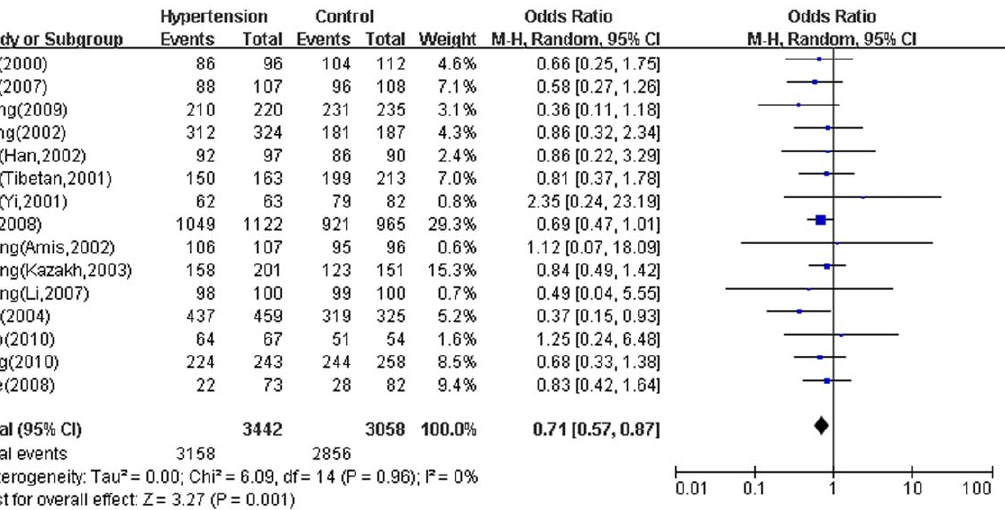
Figure 2. Meta-analysis for the overall association between the A-6G polymorphism and hypertension under the dominant genetic model. Figure 2 shows that the -6A allele carrier (AA + AG) can reduce the risk of hypertension compared to the homozygous GG genotype carriers.